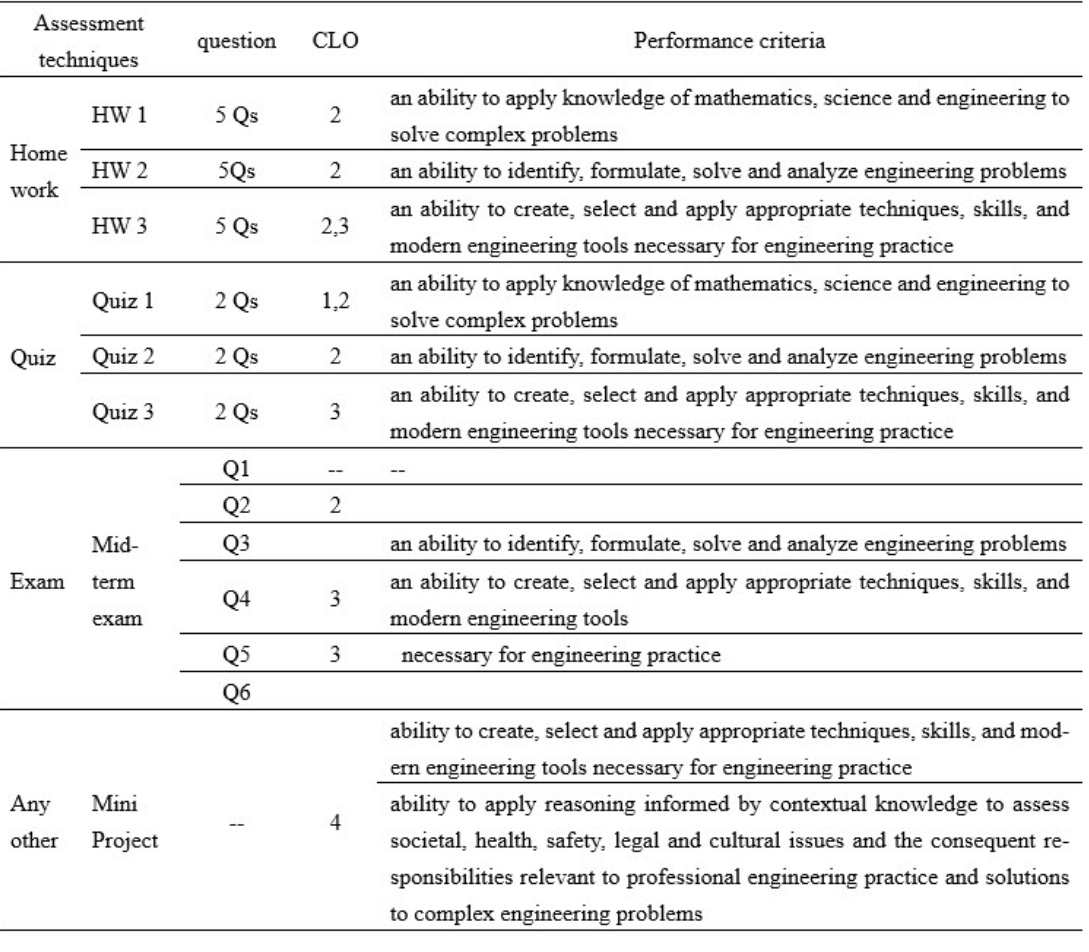
Table 5. Mapping assessments with